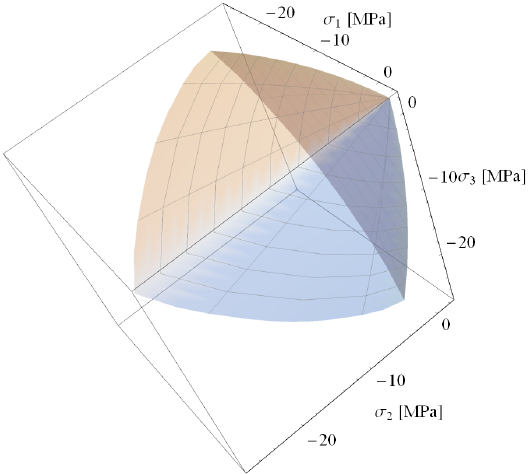
Figure 5. Three-dimensional view of the JP surface.